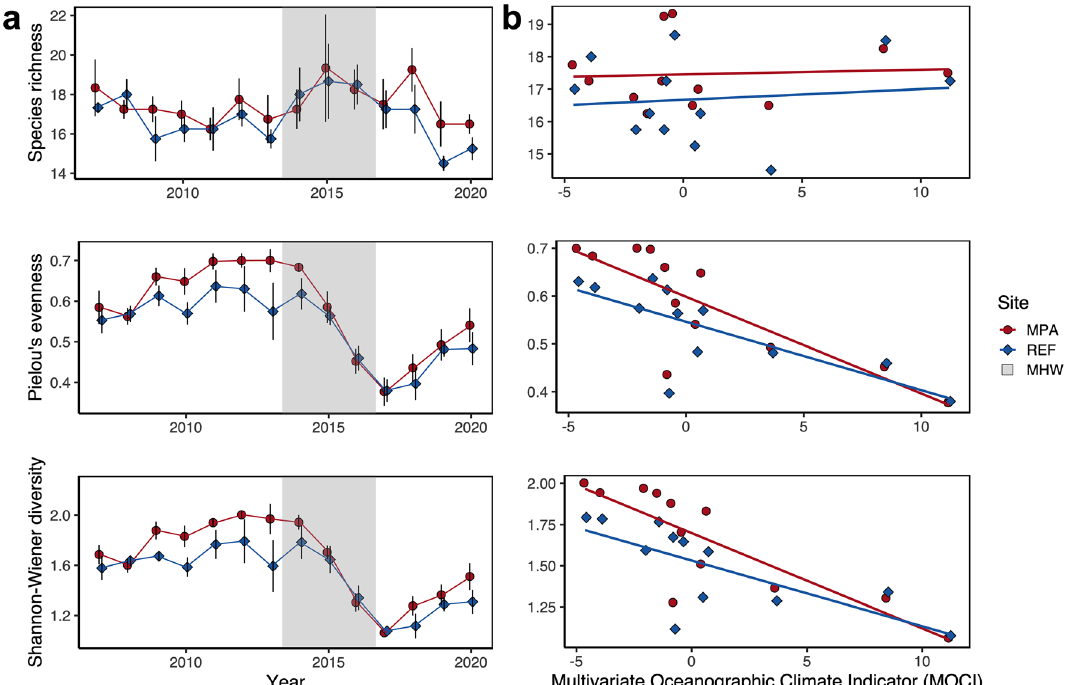
Figure 2. Changes in diversity metrics (species richness, Pielou’s evenness and Shannon–Wiener diversity) from 2007–2020 in relation to ( a ) the 2014–2016 MHW and ( b ) a 2-year lag in the multivariate oceanographic climate indicator